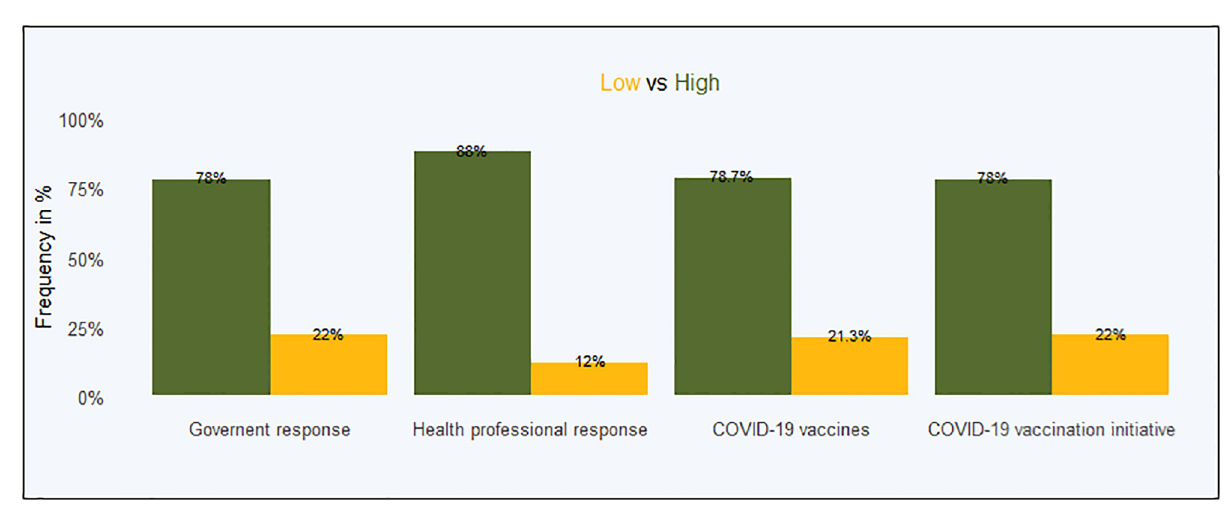
Fig 4. Overall COVID-19 related trust issues.